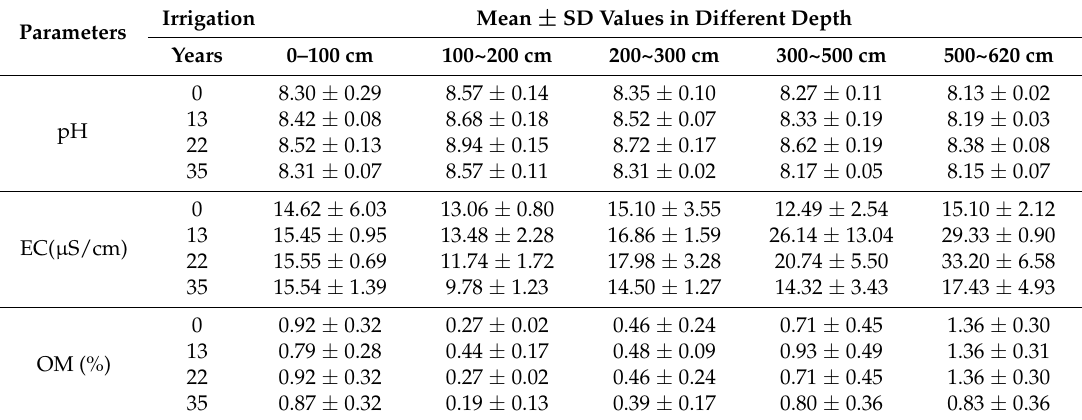
Table 4. Statistical analysis of soil characteristics in different soil depth with different irrigation